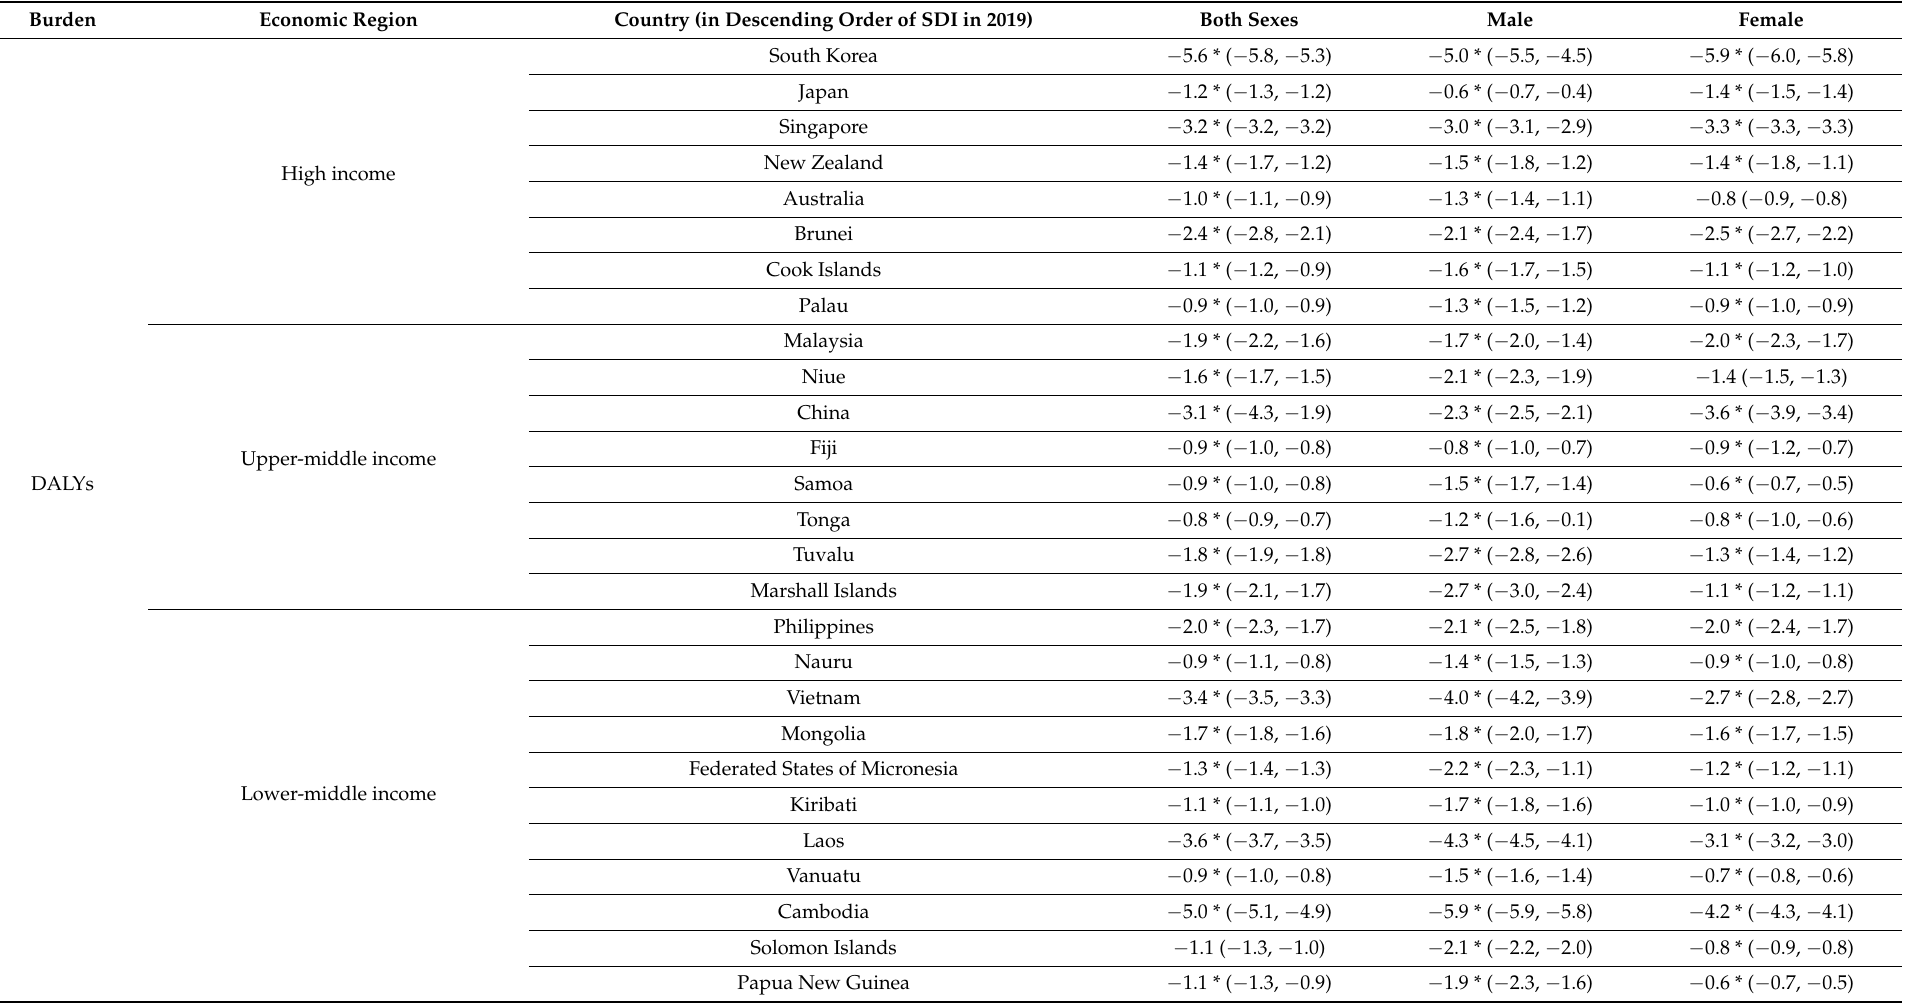
Table 2. Average annual percentage change in age-standardized DALYs and YLDs rates attributable to nutritional deficiency among older adults (65+) from 1990 to 2019, by country in the Western Pacific